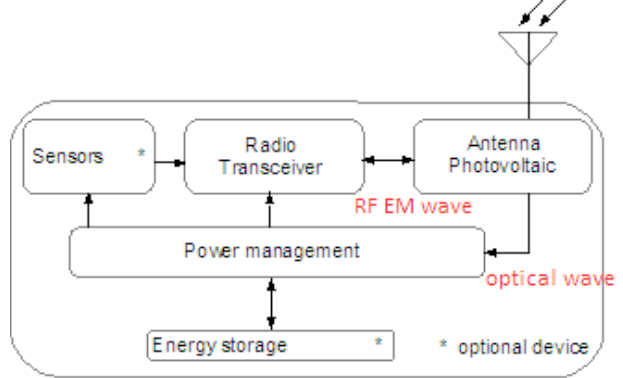
Figure6. Conventional wireless system block